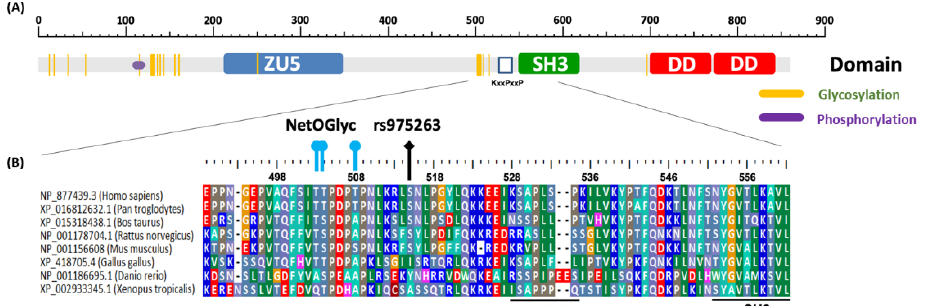
Figure 2. The diagram of putative MACC1 protein domains and predicted post-translational modification sites. ( A ) The human MACC1 protein was analyzed by using the GlycoDomainViewer. The grey bar indicates the MACC1 853 amino acids and different domains, the blue rectangle indicates the ZO-1 and Unc5-like netrin receptors domain (ZU5), the green rectangle indicates Src Homology 3 (SH3), and the red rectangle indicates the death domain (DD). The orange lines show the putative glycosylation sites and purple dots show the predicted phosphorylation residues (S112, S115, S116). ( B ) The rs975263 regions of the selected organisms were aligned, the glycosylation sites were predicted by NetOGlyc 3.0 Server and shown as lines above the sequences.